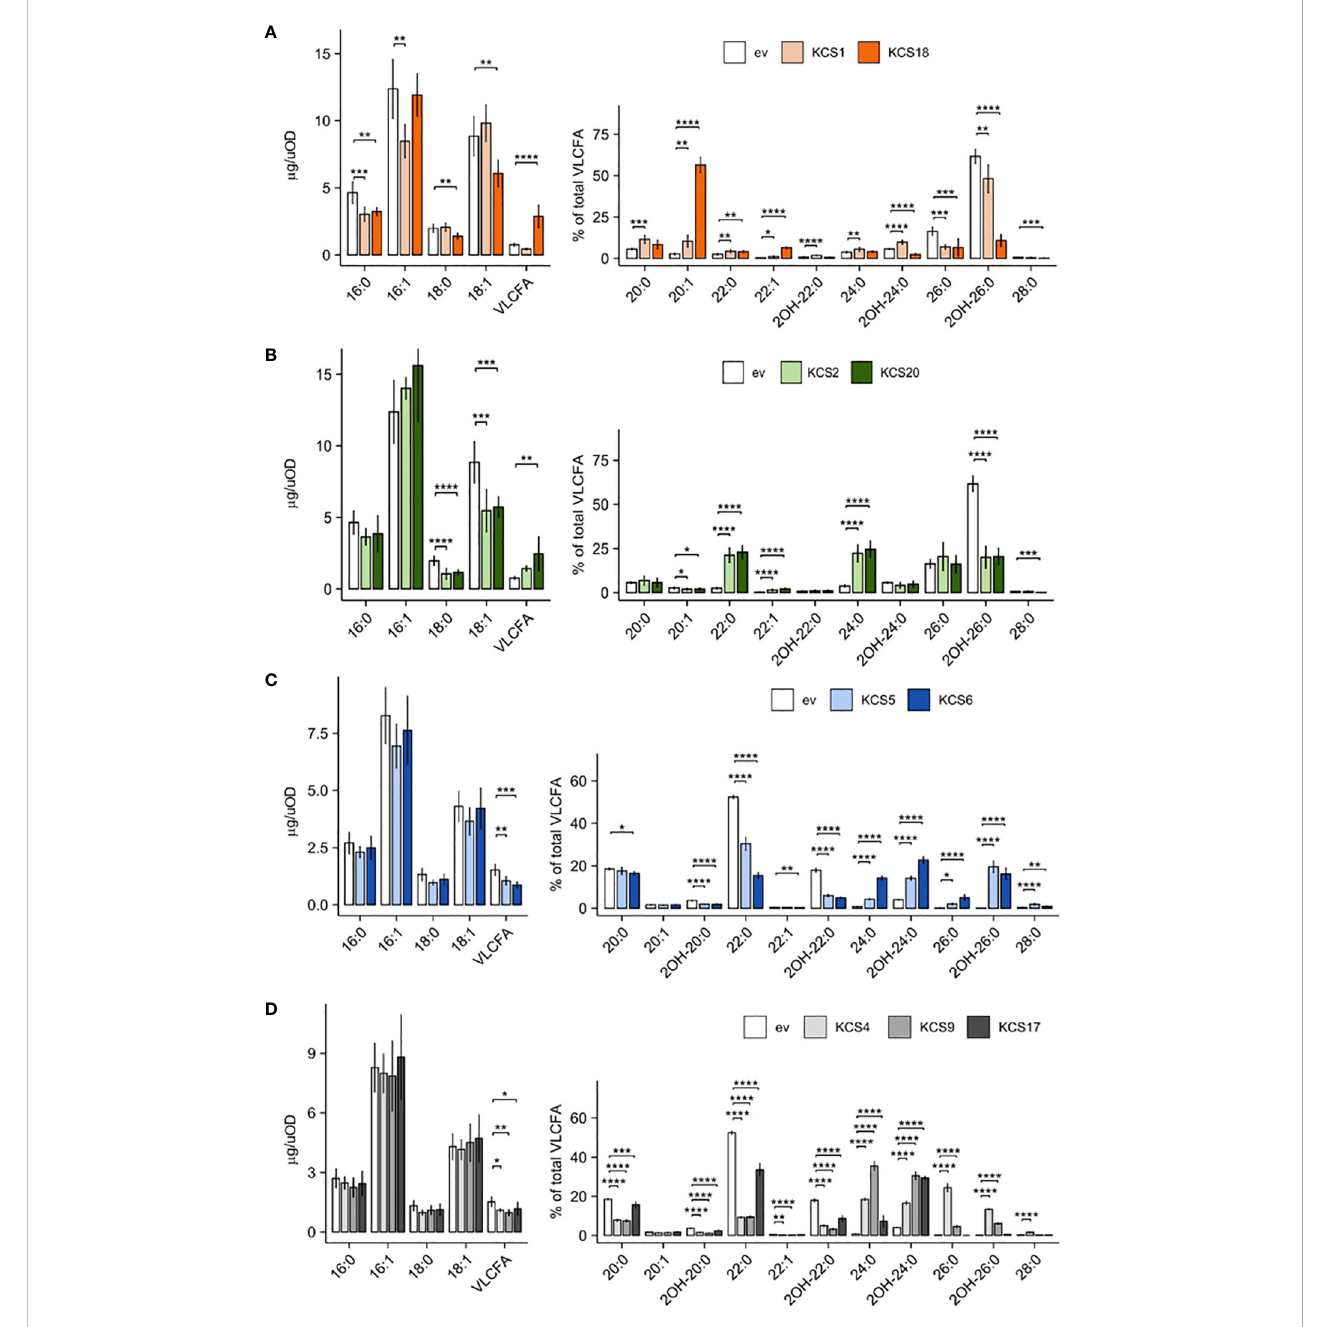
FIGURE 3 Expression of AtKCS in yeast triggers an over-production of VLCFA. Comparison of FAMEs pro fi les of TRIPLE strain (transformed with empty vector, ev) and TRIPLE transformed with KCS1 and 18 (A) , TRIPLE transformed with KCS2 and 20 (B) . Comparison of FAMEs pro fi les of TRIPLE D elo3 strain (transformed with empty vector, ev) and TRIPLE D elo3 transformed with KCS5 and 6 (C) , TRIPLE D elo3 transformed with KCS4, 9 and 17 (D) . Mean values (µg/uOD or percentage of total VLCFA) are given with SD (n = 6). Each FAME species is designated by carbon chain length and degree of unsaturation. Signi fi cance was determined with a Tukey post hoc test (*P < 0.05, **P < 0.01, ***P < 0.001, ****P < 1e -4